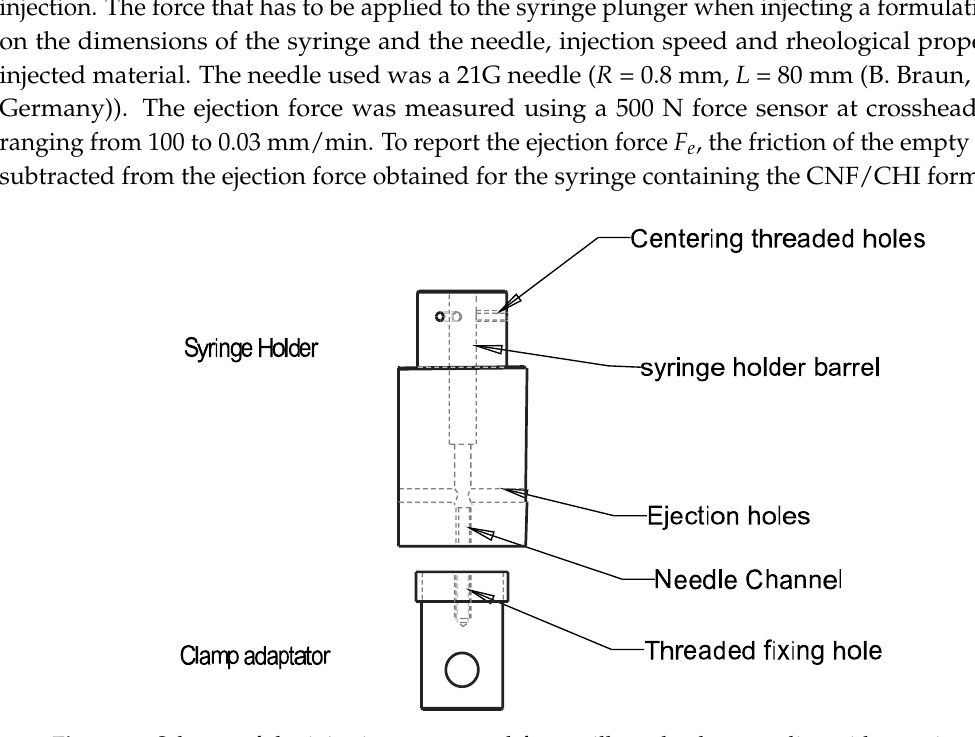
Figure 1. Scheme of the injection setup used for capillary rheology studies with a syringe holder mounted in a tensile/compression testing machine to measure the injectable formulation ejection forces Fe. The syringe body is inserted in the upper part of a barrel holder (10.8 mm diameter hole) and fixed with three polyethylene M4 screws. The needle is centered in a 6.6 mm diameter channel and the extruded formulation can be evacuated by the lateral ducts.